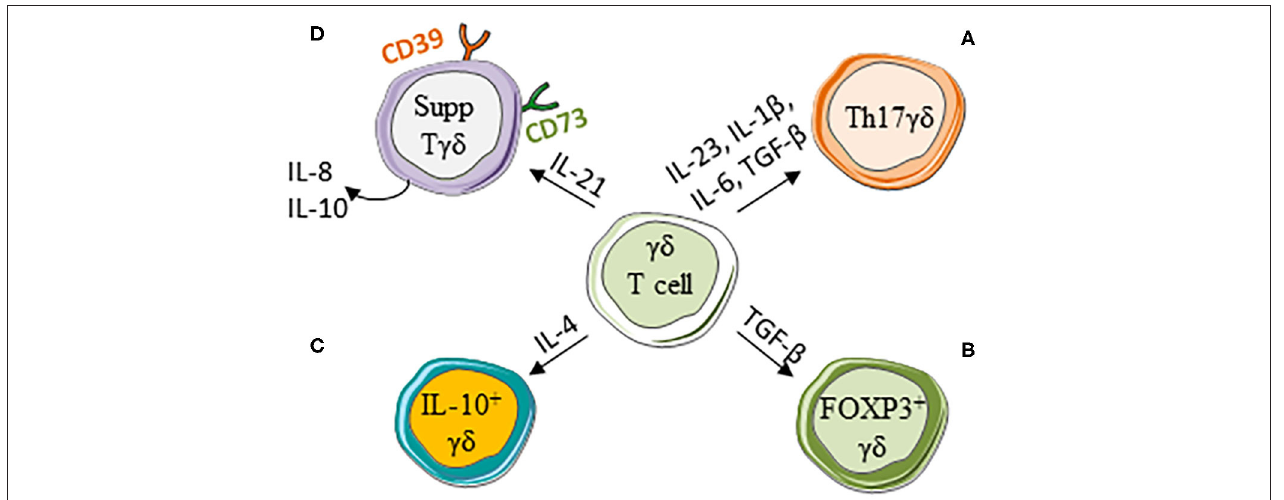
FIGURE 1 | γδ T cell polarization into pro-tumor cells. Cytokines present in the tumor microenvironment induce the differentiation of γδ T cells into pro-tumor cells: (A) Th17-like γδ T cells (Th17 γδ ), (B) FOXP3 + γδ T cells (FOXP3 + γδ ), (C) IL-10-producing γδ T cells (IL-10 + γδ ), and (D) regulatory γδ T cells that express CD39 and/or CD73 (Supp γδ